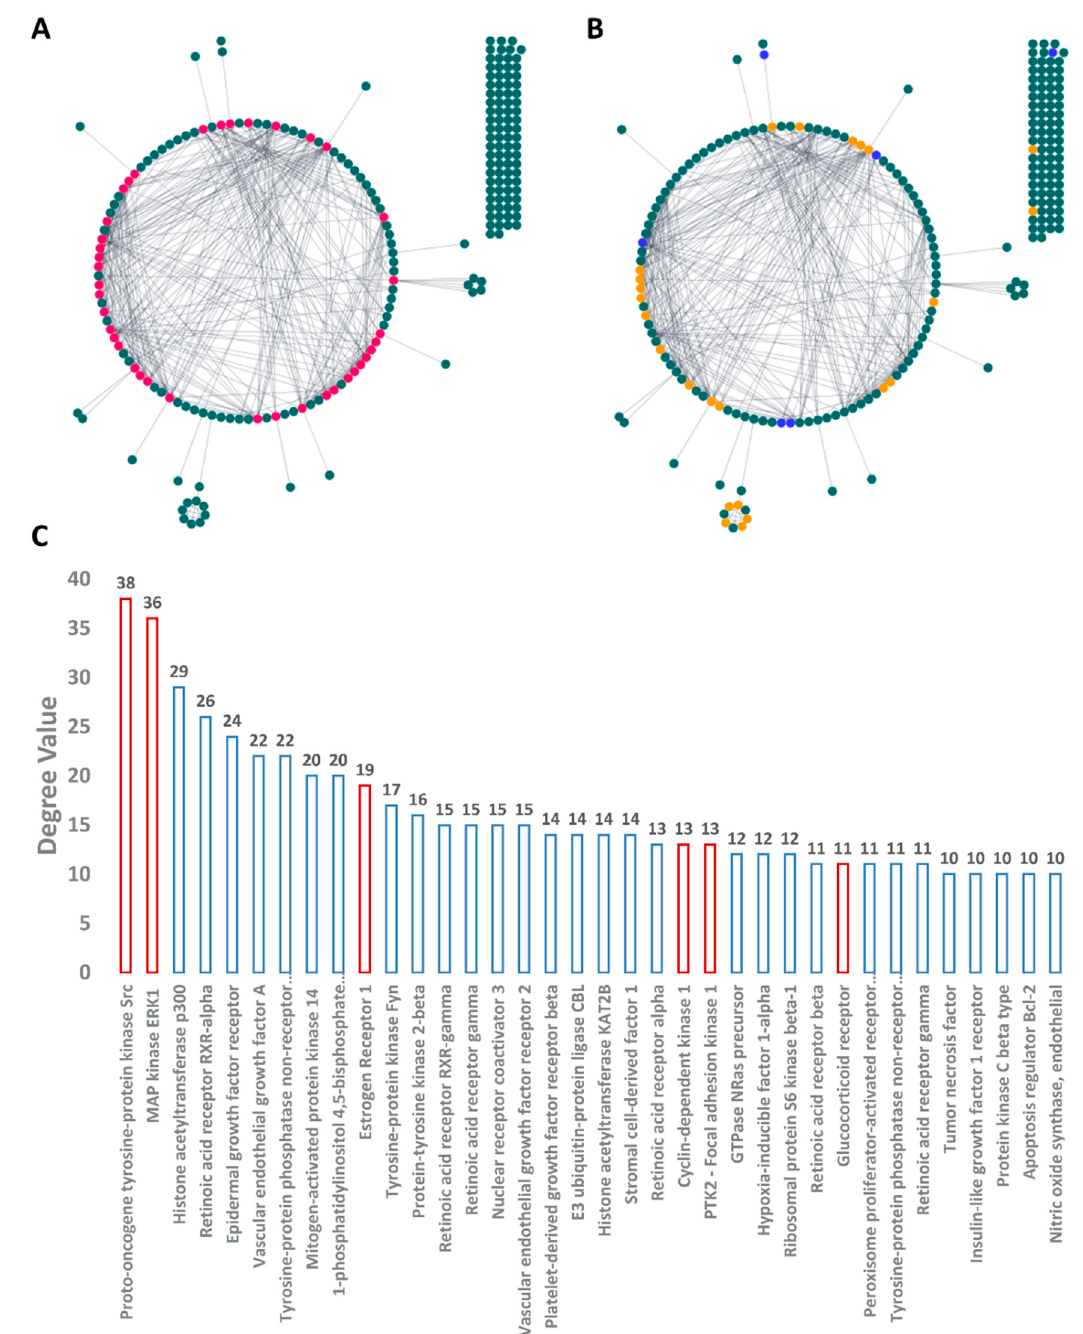
Figure 8. BC PPI networks showing the top 15% of nodes (i.e., hub proteins; red ‐ colored nodes): ( A ) the proteins that were predicted to be targeted by CE ‐ derived compounds ( 1 – 20 ; orange and blue ‐ colored nodes); ( B ) blue nodes represent the proteins that were validated by MDS and Δ G calculation as targets for CE ‐ derived compounds ( 1 – 20 ); ( C ) the top 15% nodes (i.e., hub nodes) arranged by their degree value. Orange ‐ colored columns represent the proteins found to be among the predicted targets for CE ‐ derived compounds ( 1 – 20 ).